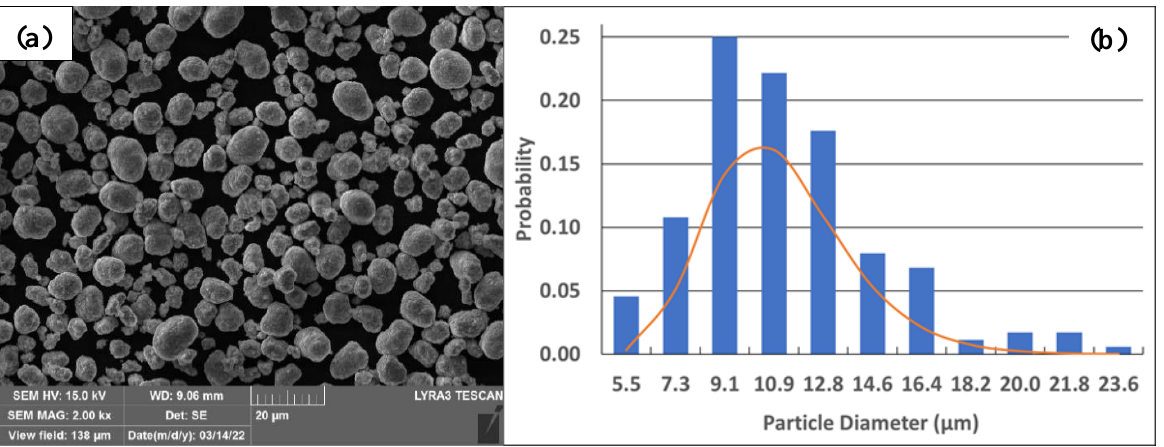
Figure 3. ( a ) SEM of the uncoated NMC-60 particles, and ( b ) approximation of NMC-60 particle sizes with log-normal distribution.